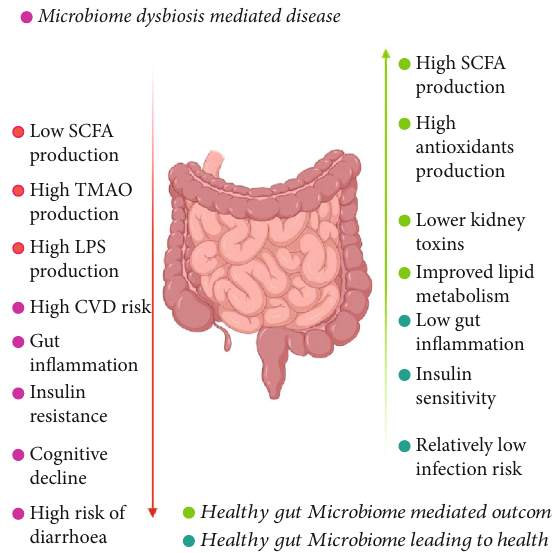
Figure 1: Schematic representation of the gut microbiota-mediated outcomes and their role in health and